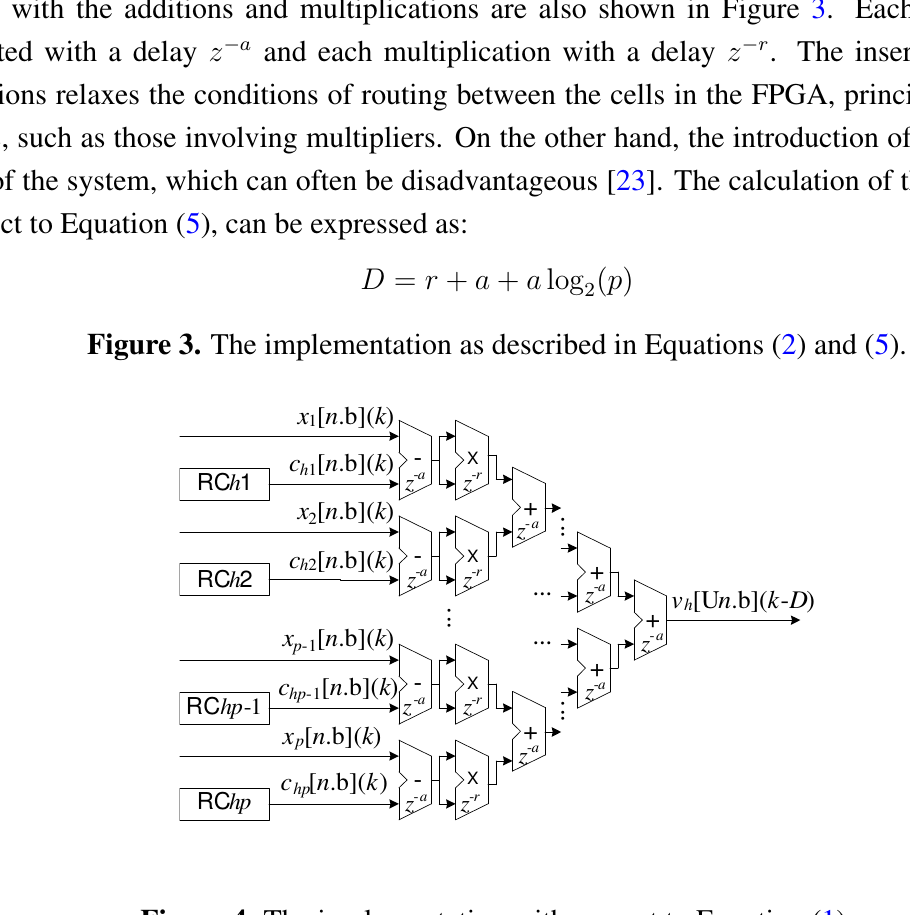
Figure 4. The implementation with respect to Equation